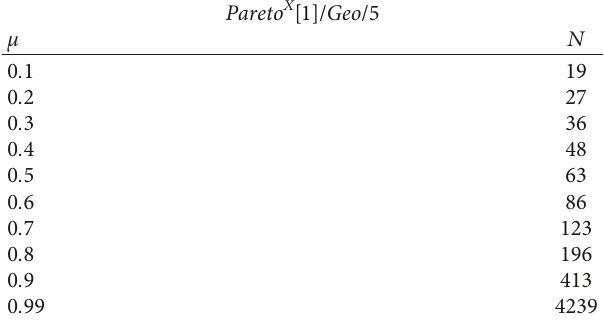
Figure 6: Plotting 1,000 roots. Table 5: Relation between μ and N